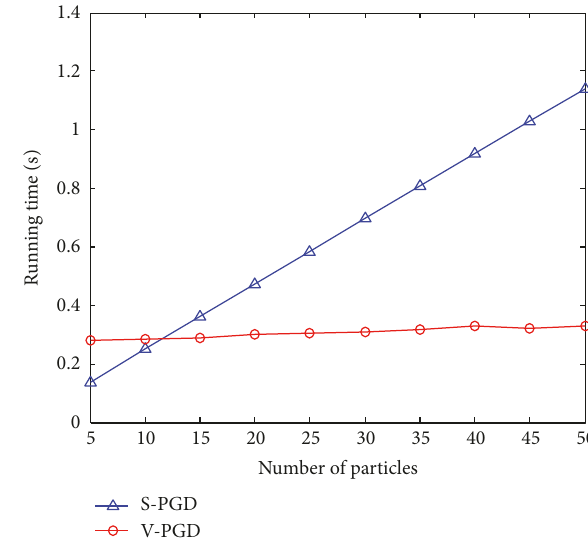
Figure 8: Running times of g14 ( n = 30 and Itr =